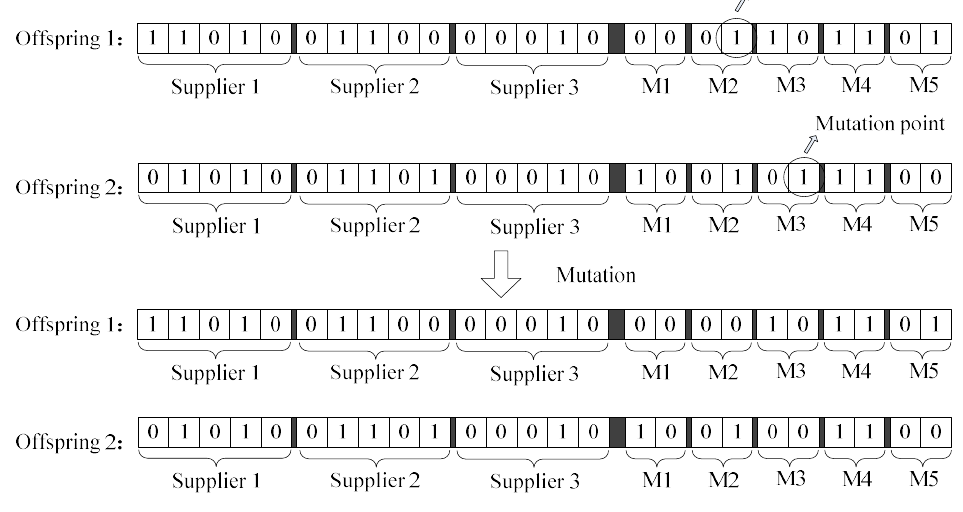
Figure 8. The process of Mutation.